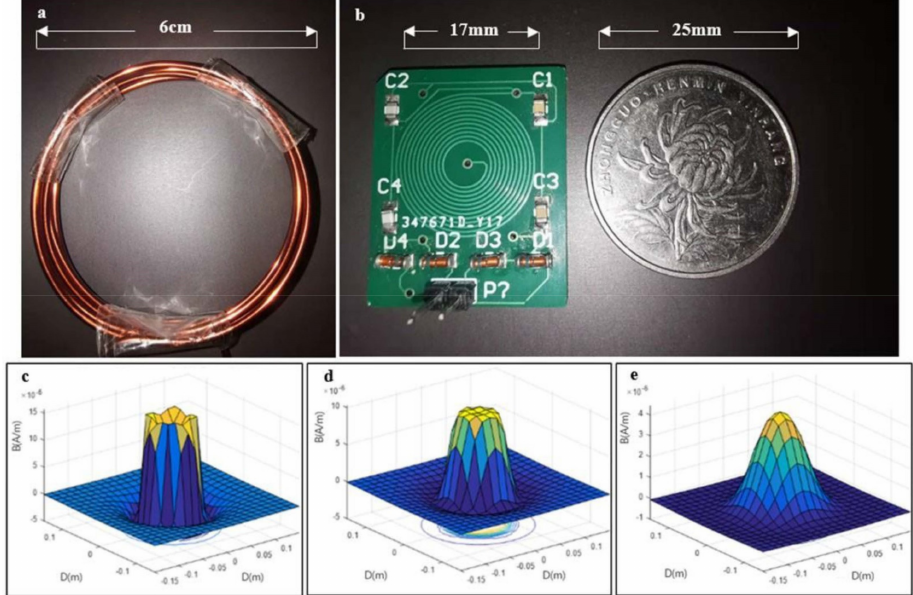
Figure 6. The fabrication of coils: ( a ) The T X coil; ( b ) The R X coil and receiving circuit on the left; ( c ) The magnetic field stimulation of T X coil on the plane with transmission distance D = 1 cm; ( d ) D = 2 cm; ( e ) D = 5